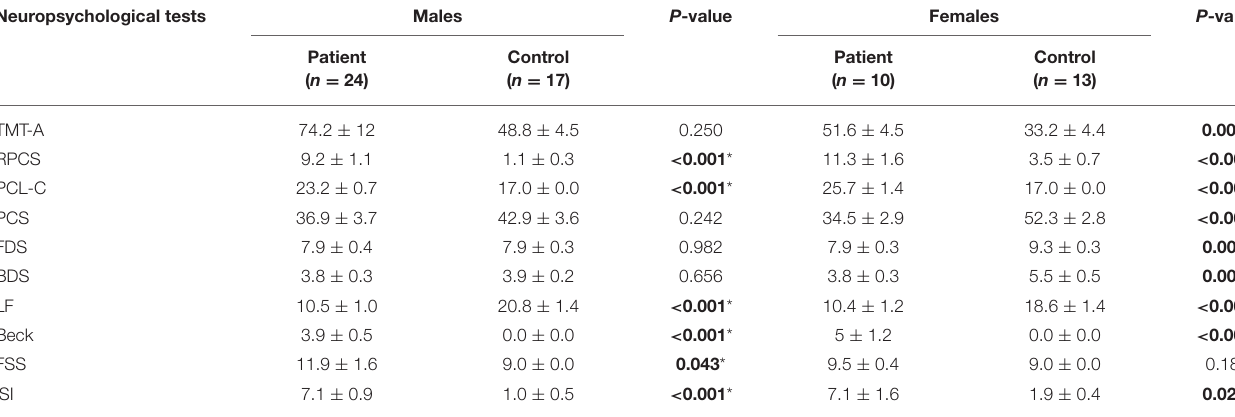
TABLE 2 | Neuropsychological tests outcomes in patients with mTBI and healthy controls. Neuropsychological tests